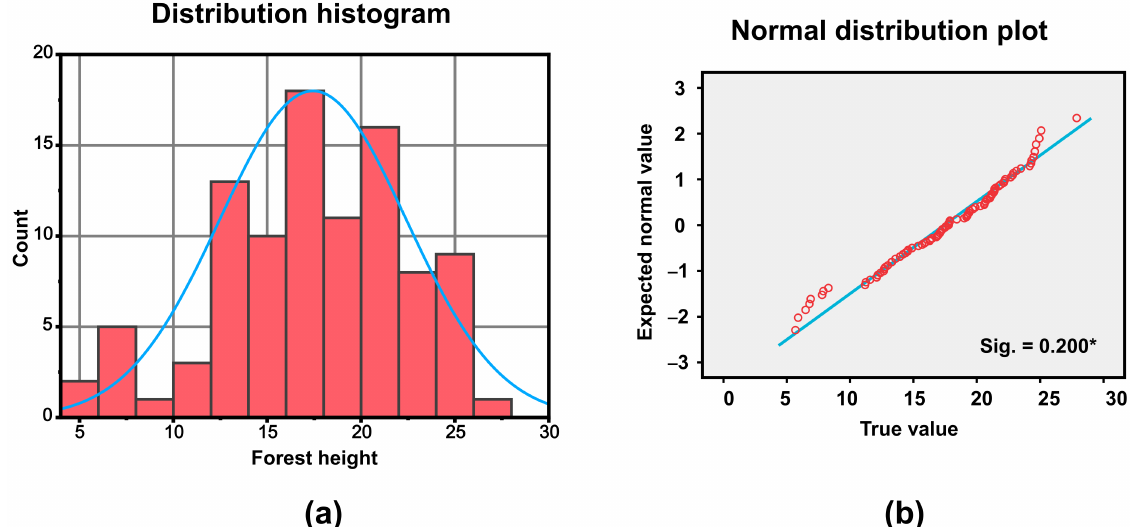
Figure 3. ( a ) Histogram of the distribution of the sample forest heights. The blue curve is the normal distribution curve. ( b ) Scatterplot of samples, normal distribution. The red points are the true distribution of the samples, and the blue line represents the standard normal distribution. The significance value Sig. was verified at the 0.05 level (*). And the samples showed a significant normal distribution after they were tested for normal distribution using the k–s